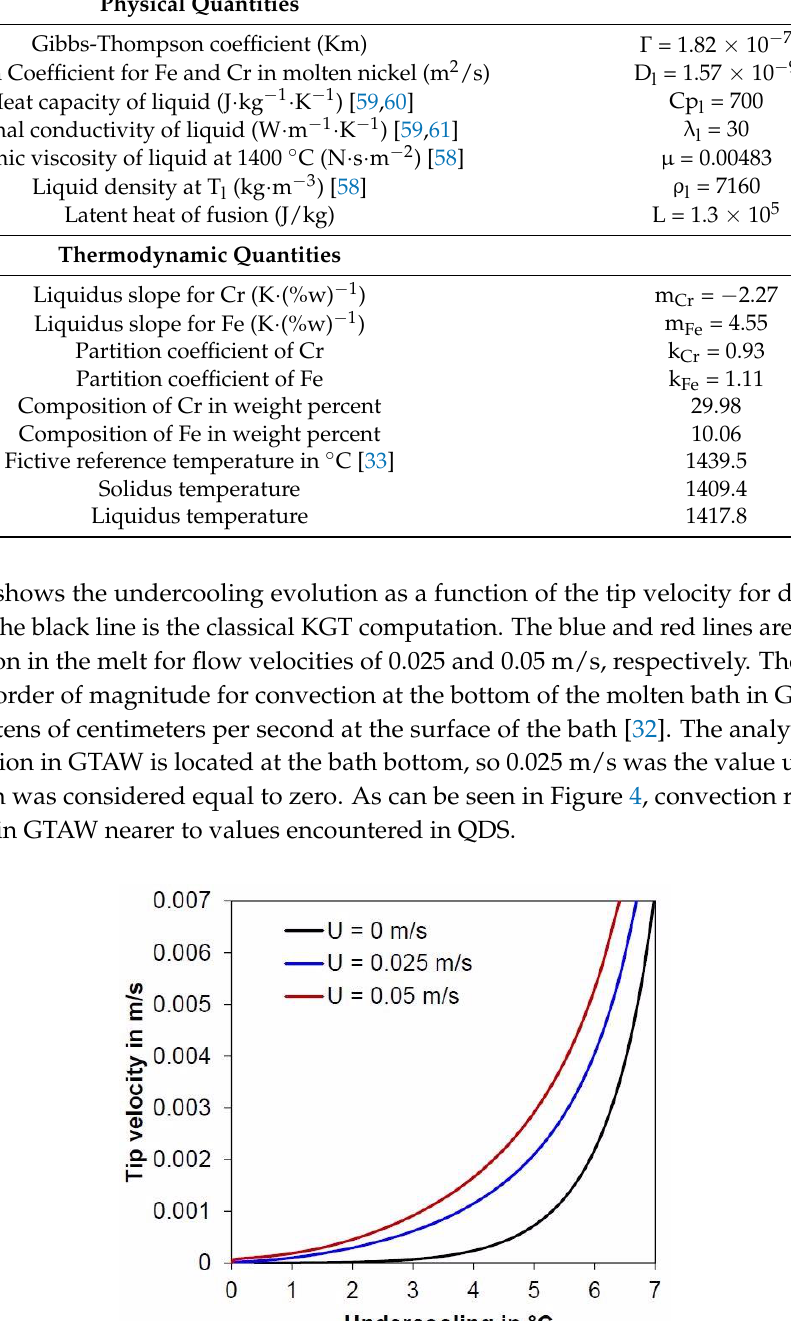
Figure 5. Comparison between microsegregation profile and Tong–Beckermann (TB) model for QDS experience for chromium and iron for GV = 0.16 K/s.